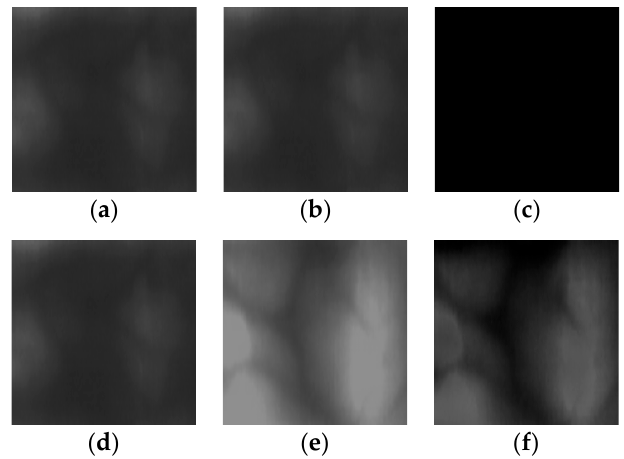
Figure 5. Examples of the difference image between the enrolled and matching images. ( a ) Enrolled image, matching image of the same class as ( a – c ) difference image of ( a , b ) enrolled image, matching image of class different to ( d – f ) difference image of ( d , e ).